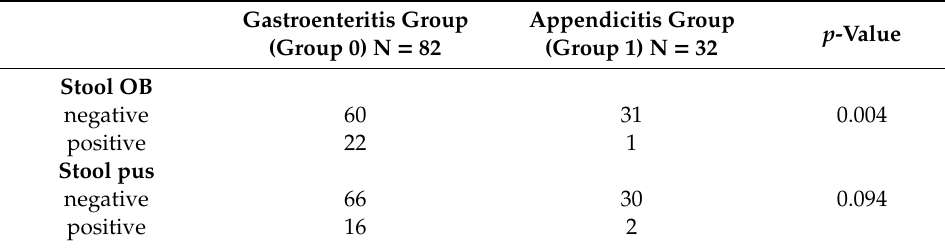
Table 2. The stool analysis between the two groups.